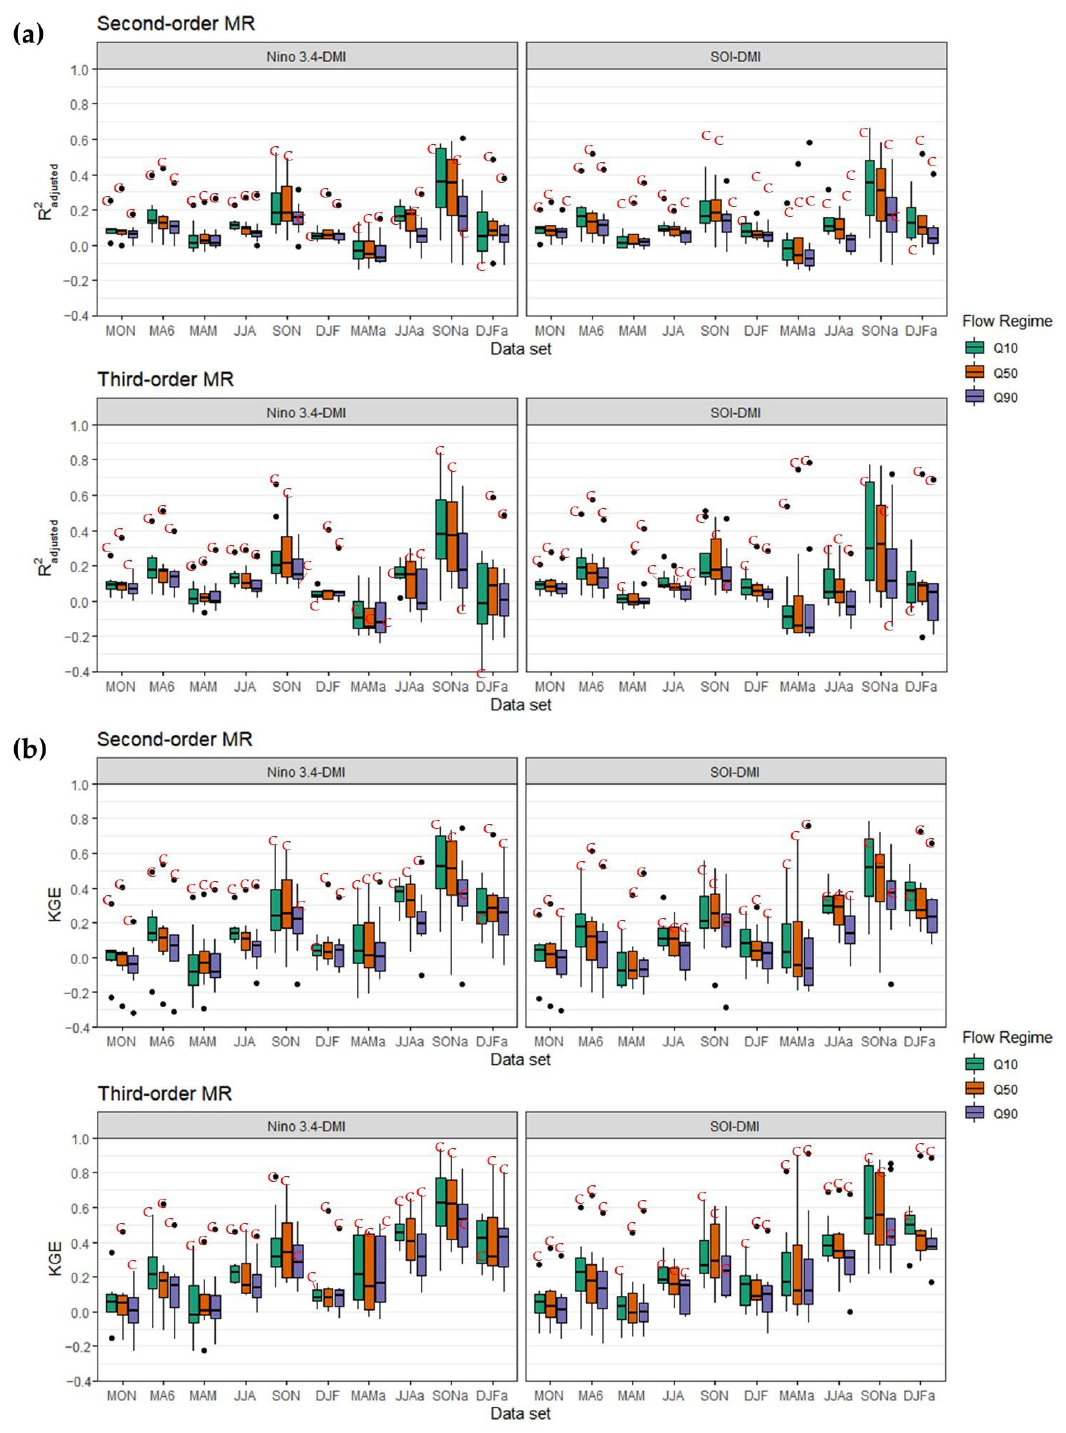
Figure 3. Boxplot series showing model’s evaluation metrics of ( a ) adjusted R 2 and ( b ) KGE coefficient with two variants of predictor combinations: NINO 3.4-DMI and SOI-DMI. The x -axis shows the temporal variation sets (MON: monthly flow, MA6: six-month moving average flow, MAM-DJF: monthly flow in the window of each respective season, MAMa-DJFa: three-month average flow in the window of each respective season). C = Code River. The lines in the middle of the box are median. The top of the box is the third quartile (Q3), and the bottom is the first quartile (Q1). The vertical lines above and below the box show the data range, excluding outliers. The dots represent outliers, values that are farther than 1.5 times of their interquartile ranges (IQR = Q3 − Q1).